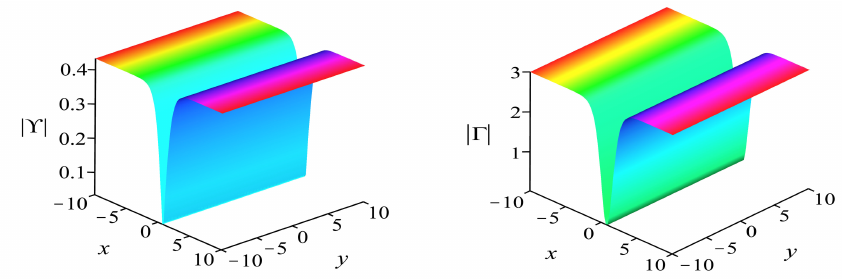
Figure 5. The evolution of solution (62) with α = 0.5, β = γ = ω = 2, ν = λ = η = 1, σ = − 2, h = − 4, z = − 0.5, and t =